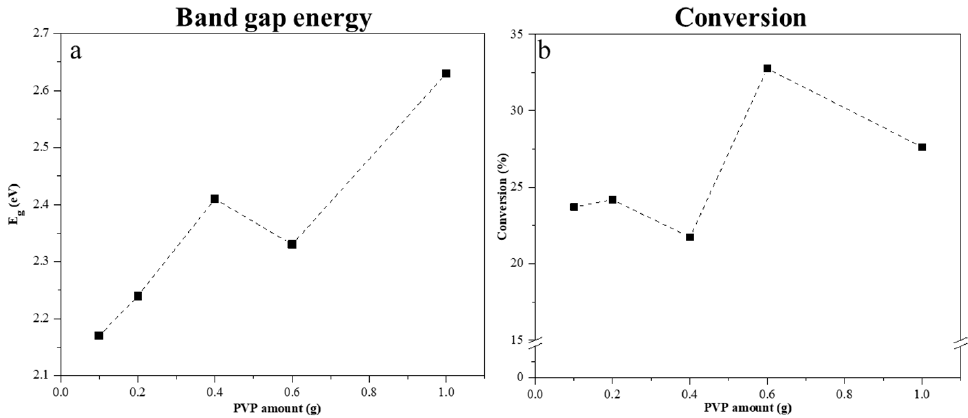
Figure 6. Effect of PVP amount on ( a ) the band gap energy and ( b ) conversion values.